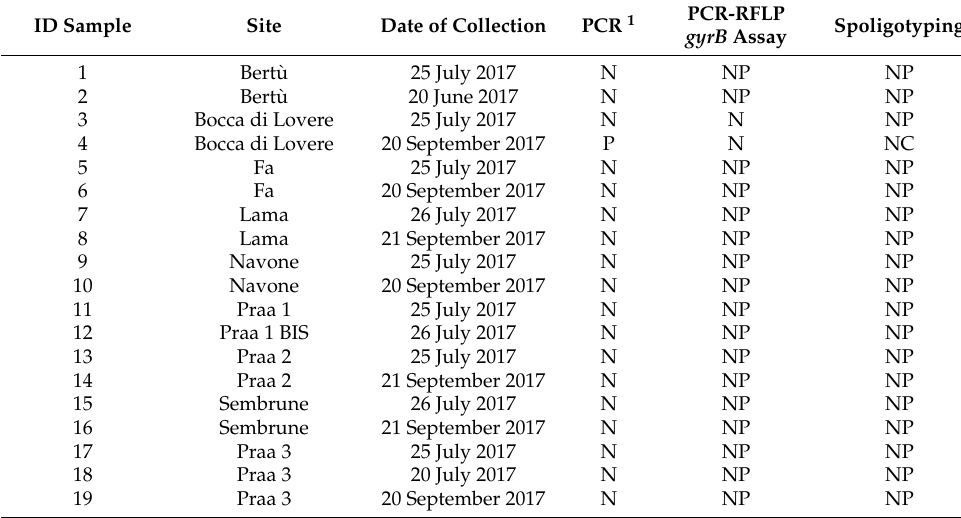
Table 5. Analysis of mud samples from field sites (P = positive, N = negative, NP = not performed; NC = not